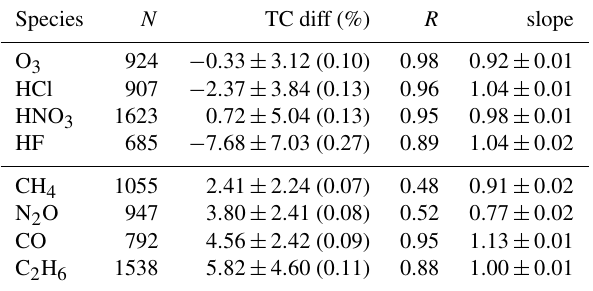
Table 3. Comparison of PARIS-IR and the smoothed Bruker 125HR total columns for all trace gases in this study, averaged between 2007 and 2013. N is the number of coincident pairs involved in this calculation. The third column (TC diff) represents the mean differ- ences between the total columns of the two FTSs (in %) along with the 1 σ standard deviation and the standard error (1 σ/ ets). The correlation coefficient ( R ) and the slope of the regression plot (slope), along with the uncertainty of the slope, are shown in columns 4 and 5,